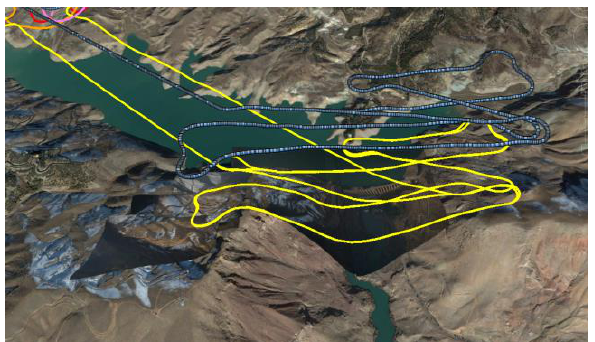
Figure 5. The results of the geolocation process for some of image frames over different parts of the area